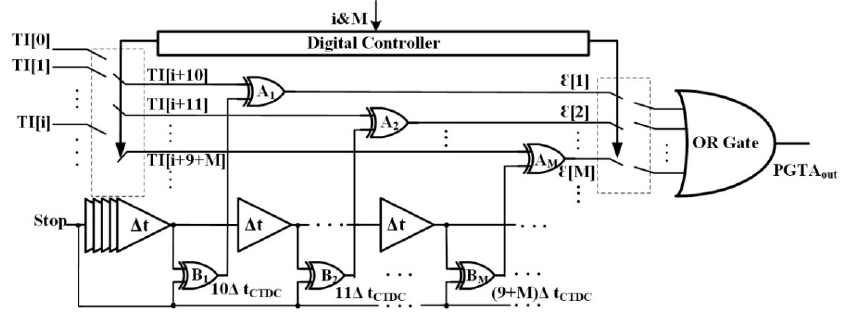
Figure 9. Structure of the PGTA.